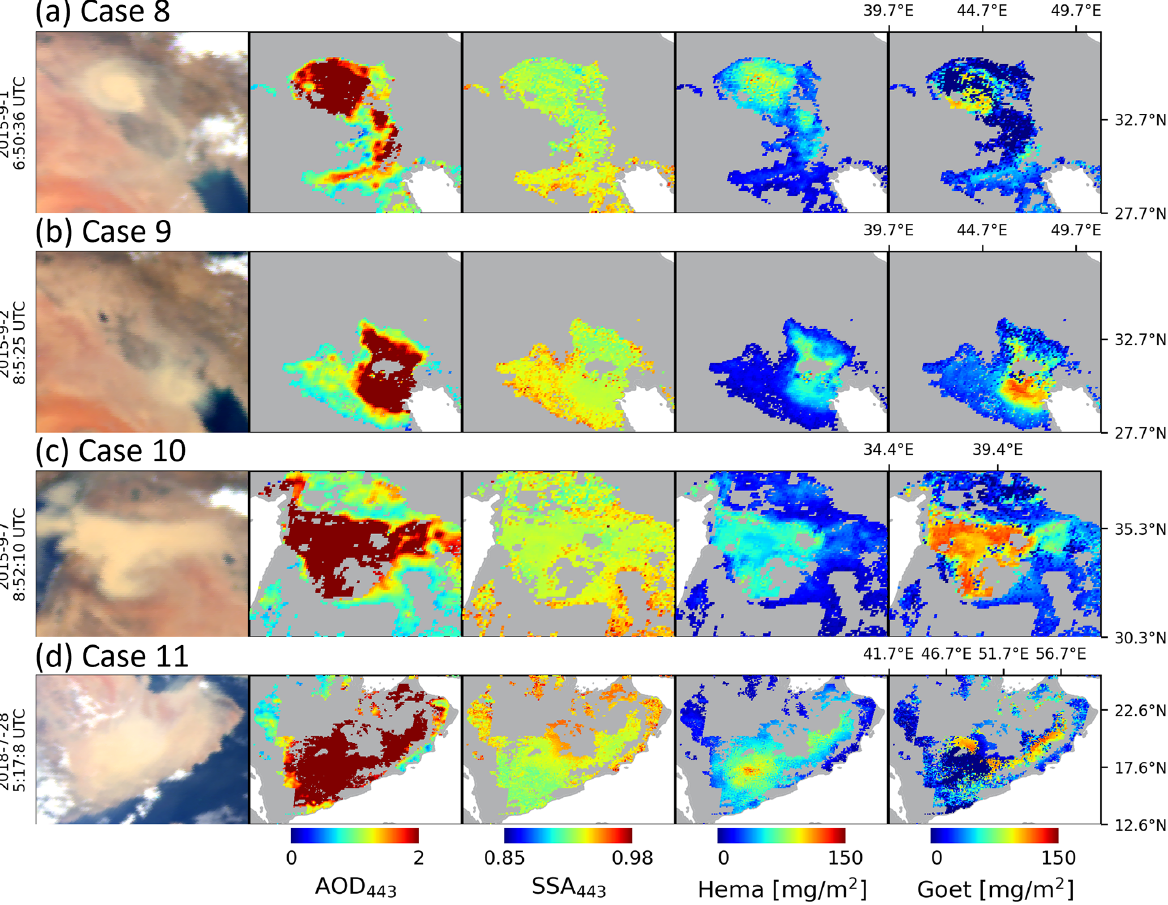
Figure A2. Dust episodes over the Middle East. From left, RGB TOA image generated from EPIC L1B version 3 data, AOD 443nm, SSA 443nm, hematite mass concentration, and goethite mass concentration for each case: case 8 (row 1), dust episode on 1 September 2015; case 9 (row 2), dust episode on 2 September 2015; case 10 (row 3), dust episodes on 7 September 2015; and case 11 (row 4), dust episode on 28 July